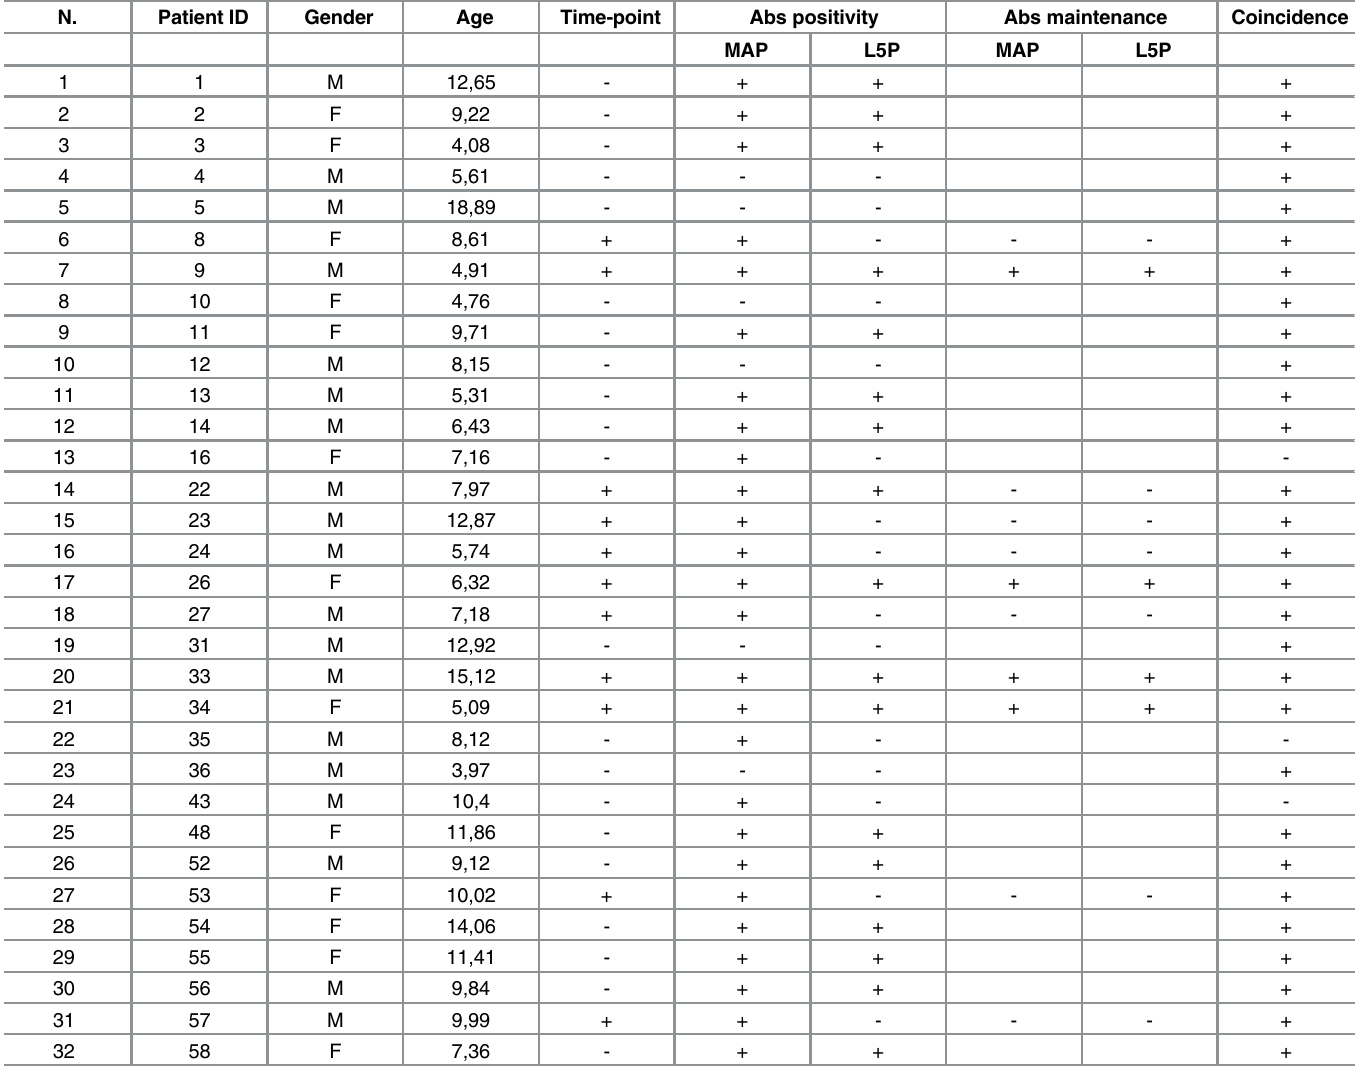
Table 1. Clinical characteristics and Abs status in T1D at-risk subjects. Plus signs and hyphens indicate, respectively, the presence or absence of avail- able time-point samples, Abs directed against MAP homologous peptides and L5P antigen with their maintenance in time, as well as coincidence of Abs sta- tus for both types of epitopes.